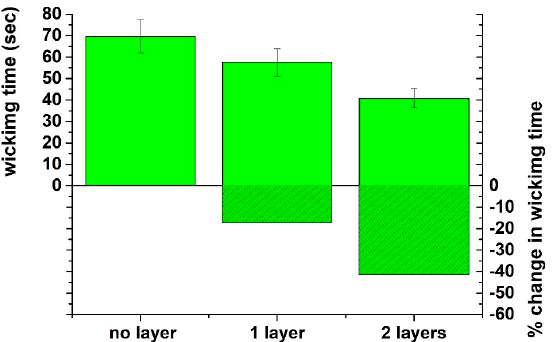
Figure 4. Decrease in wicking time induced by 1 and 2 overlaying wax-printed (fully hydrophobic) layers and percentage decrease in wicking time compared to regular (open) channels. According to Newton’s law of flow, the application of stress on a liquid leads to flow in direct proportion to the amount of stress applied. The overlaying hydrophobic layers repel the water, forcing it to move along the only favorable route, which is the hydro- philic fluid path, thus accelerating the flow rate. When two layers are used to fully en- close the hydrophilic zone, the flow is confined, creating a rectangular hydrophilic duct surrounded by hydrophobic barriers (top, bottom and sides). Hence, the phenomenon becomes more intense and movement along the hydrophilic path is greatly enhanced. Importantly, the evaporation of water is minimized, which further contributes to the higher flow rate. A conceptual representation of the potential flow regime on these de- vices is depicted in Figure S2.